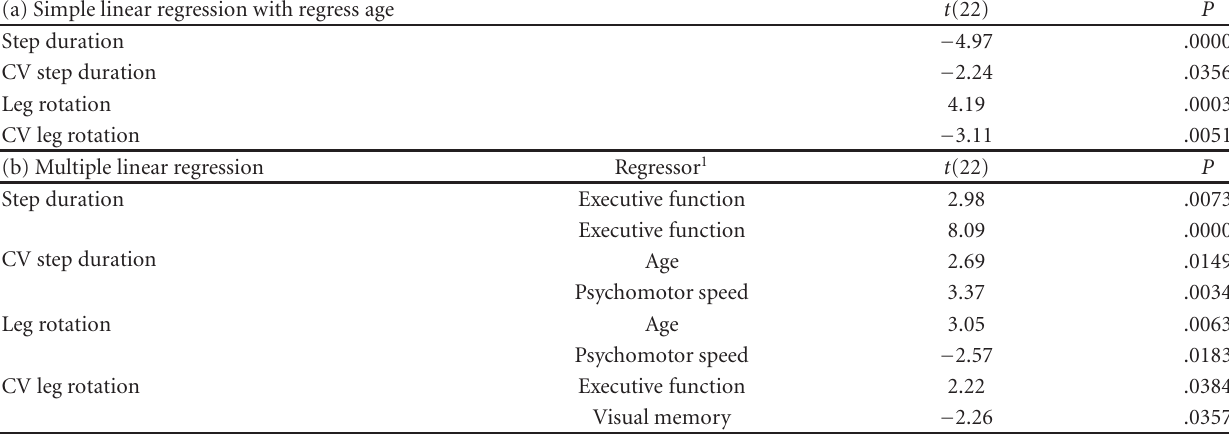
Table 2: Outcome of linear regression